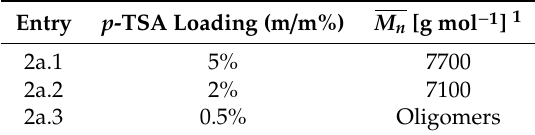
Table 2. Screening of p -TSA catalyst